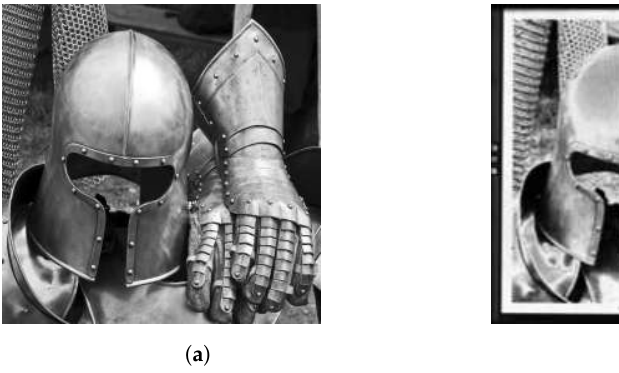
Figure 10. Calibration result based on optical profilometry [30]. ( a ) Original image. ( b ) Camera image taken with uncalibrated mirrors, the wrong gray values, and noise due to the spread in mirror response, as well as systematic pre- deflection. ( c ) Camera image taken with calibrated